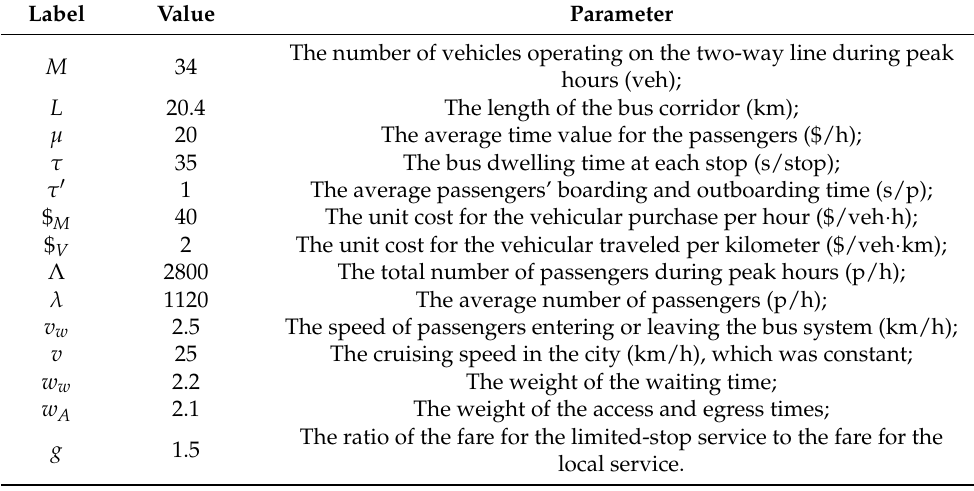
Figure 2. No. 115 bus stops. Table 1. The input values of the parameters.